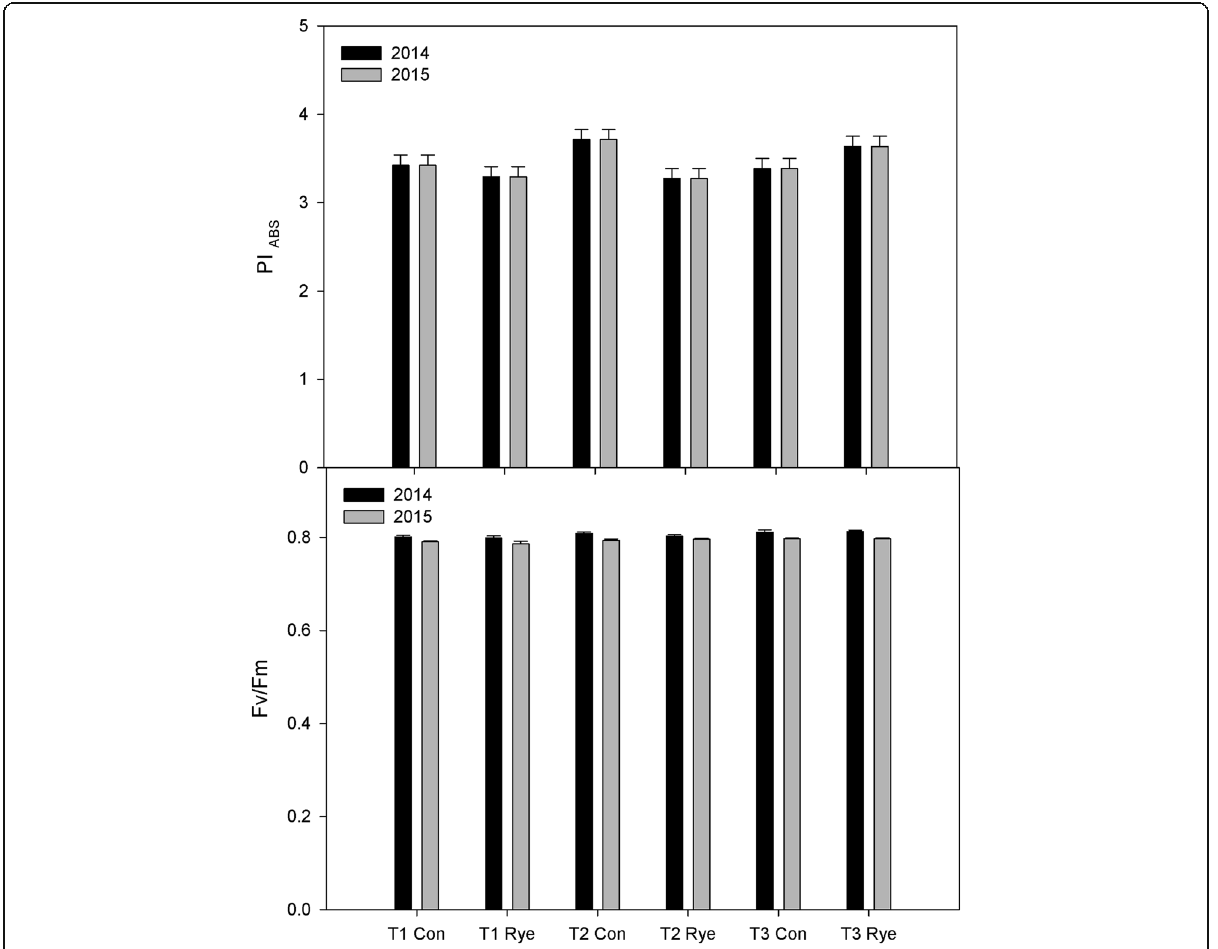
Fig. 8 Photosynthetic performance index (PI ABS ) and maximum quantum yield of photosystem II (F v /F m ) for the 2014 and 2015 cotton crop grown under irrigation regimes T1-T3 and planted into either conventionally tilled beds (Con) or a heavy rye cover crop residue (Rye) during the 2014 and 2015 growing seasons at a field site near Tifton, GA. Values are means ± standard error ( n =